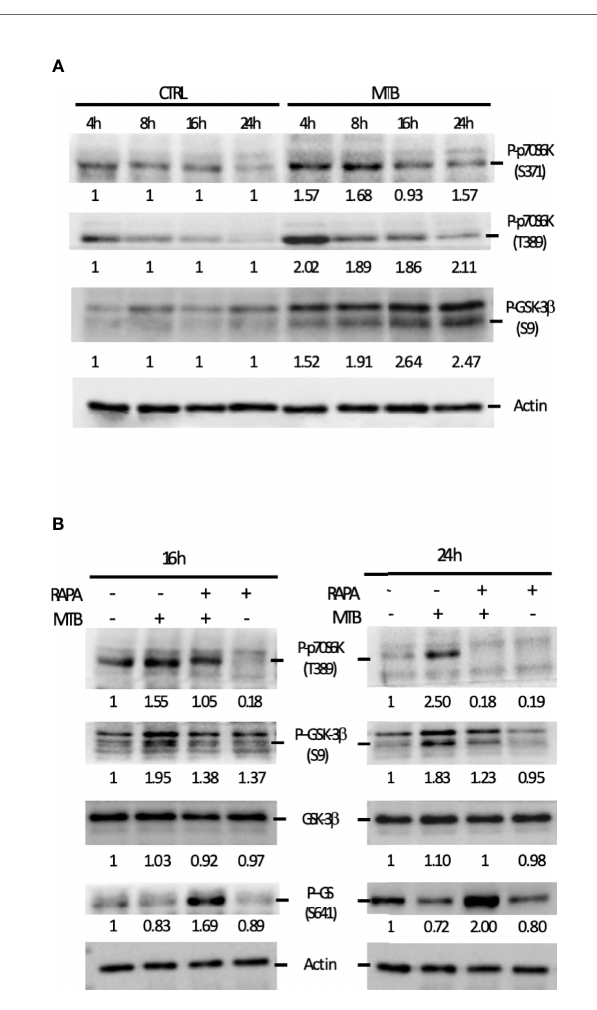
FIGURE 7 | Analysis of the signaling cascades modulated by Mtb alone or in combination with rapamycin and leading to cytokine production. (A) DC were left untreated (CTRL) or infected with Mtb (MTB) in kinetic. Activation of p70S6K and GSK-3 b was investigated by western blotting on whole cell extracts. Quanti fi cation of the phospho-p70S6K (S371 and T389) and phospho-GSK-3 b (S9) bands is shown below each immunoblot. (B) The impact of rapamycin on p70S6K and GSK-3 b was investigated at the indicated time points in DC left unstimulated (CTRL) or infected with Mtb alone (MTB) or in presence of rapamycin added 4 h after infection (MTB+RAPA). Quanti fi cation of phospho- p70S6K (S371 and T389), total GSK-3 b , phospho-GSK-3 b (S9) and phospho- GS (S641) is shown below each immunoblot. Actin levels were analyzed to verify protein content. A representative experiment out of 3 experiments that yielded similar results is